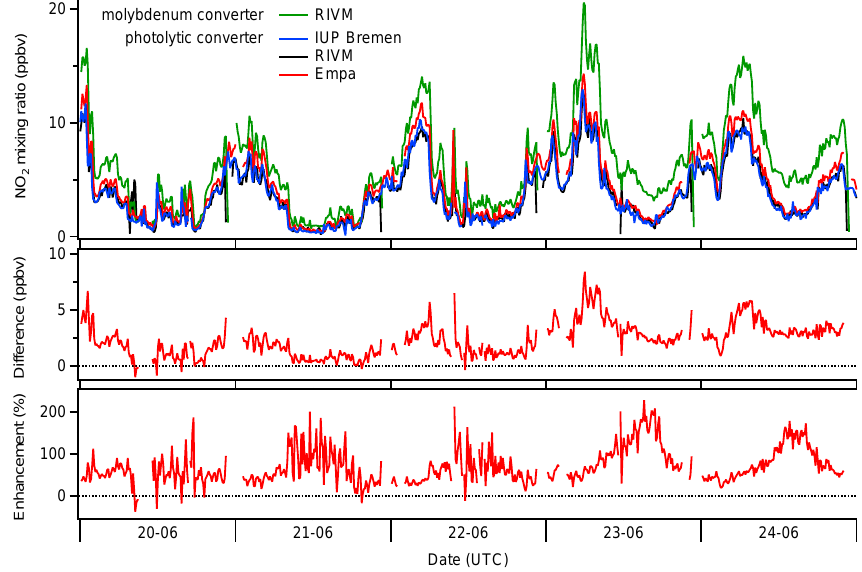
Fig. 13. Top panel: comparison of four in-situ atmospheric NO 2 sampling instruments. The green line represents the instrument with a conventional hot-plate molybdenum converter, whereas the black, red and blue lines represent the instruments with a photolytic converter, from RIVM, Empa, and IUP Bremen, respectively. The middle and lower panels show the absolute and relative difference (enhancement) between the mixing ratio derived from the instrument with molybdenum converter and the average mixing ratio derived from the three other